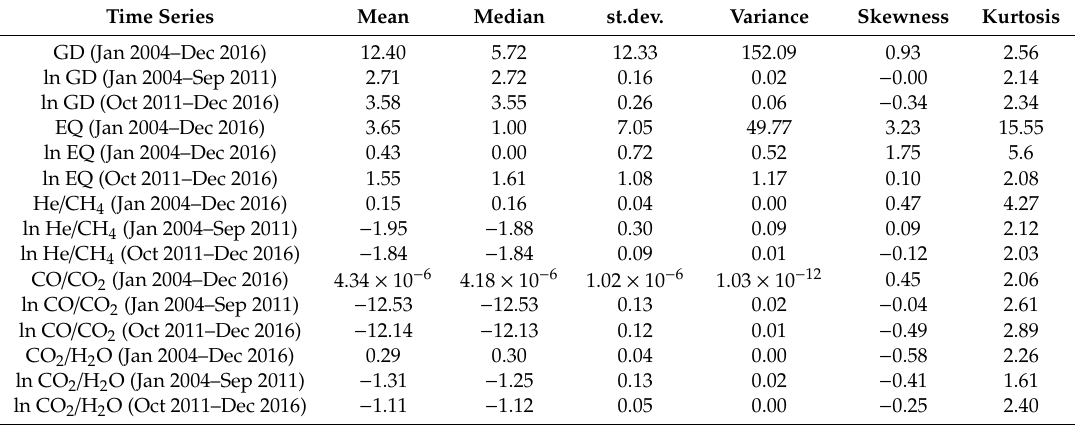
Table A1. Statistics of time series in the whole period and in the two